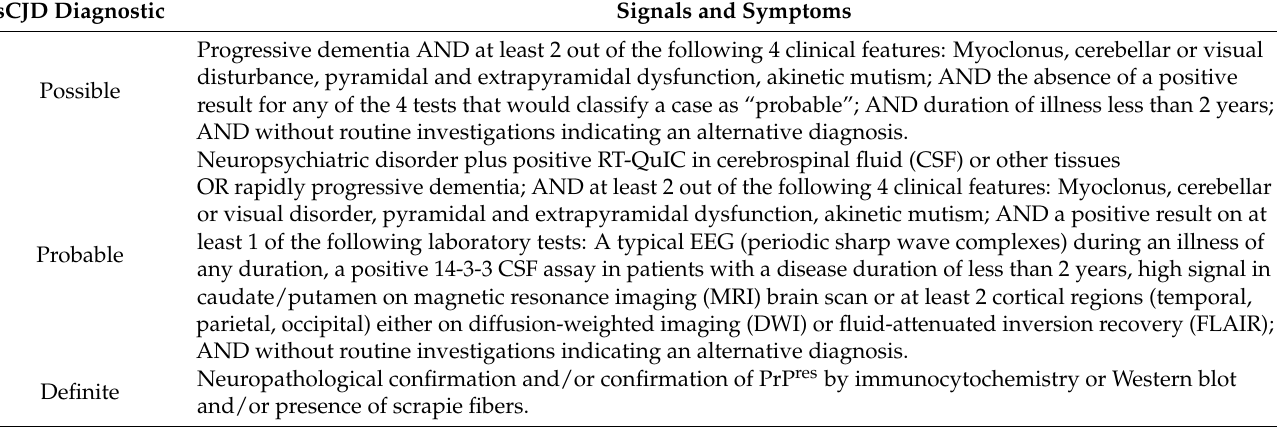
Table 2. ECDC and CDC current guidelines for sCJD